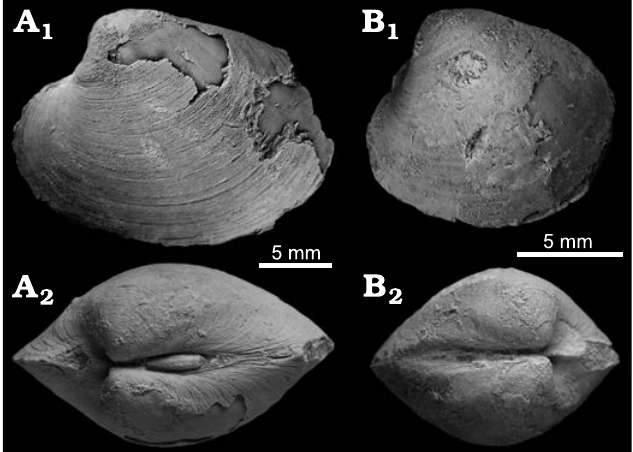
Fig. 16. Small vesicomyid bivalves from Upper Miocene seep deposits of the Amlang Formation in Pangasinan province, Luzon, Philippines. A . Vesi comyidae gen. et sp. indet. 1, NRM Mo 192444, articulated spec- imen, view on LV (A 1 ) and view on dorsal side showing lunular incision and ligament (A 2 ). B . Vesicomyidae gen. et sp. indet. 2, NRM Mo 192426, articulated specimen, view on LV (B 1 ) and view on dorsal side showing lunular incision and escutcheon (B 2